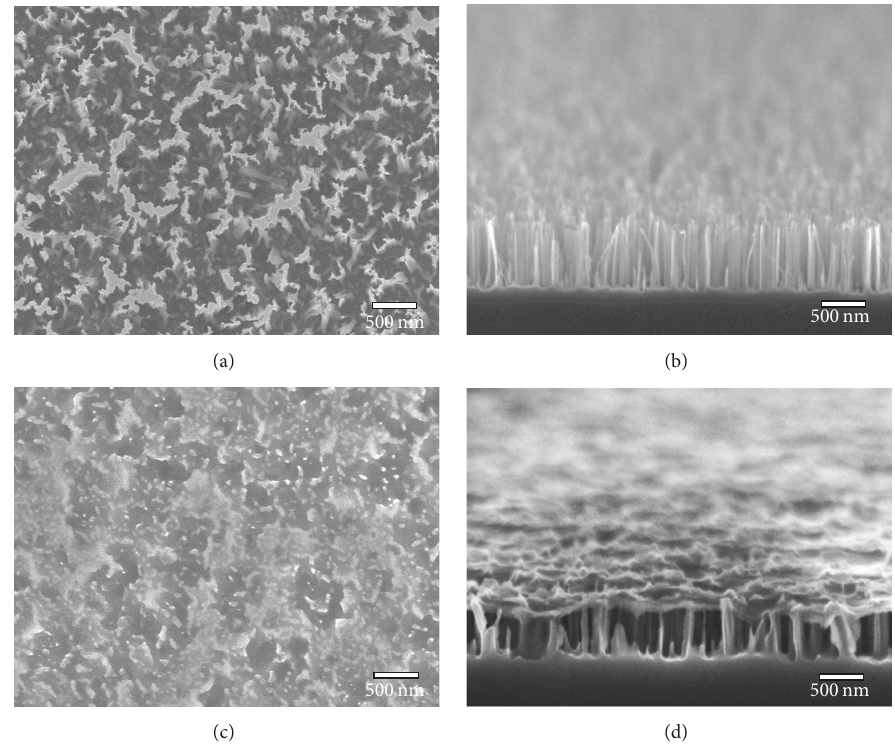
Figure 3: Top-viewed and cross-sectional SEM images of (a-b) SiNW arrays and (c-d) after coated PEDOT:PSS/Gr.